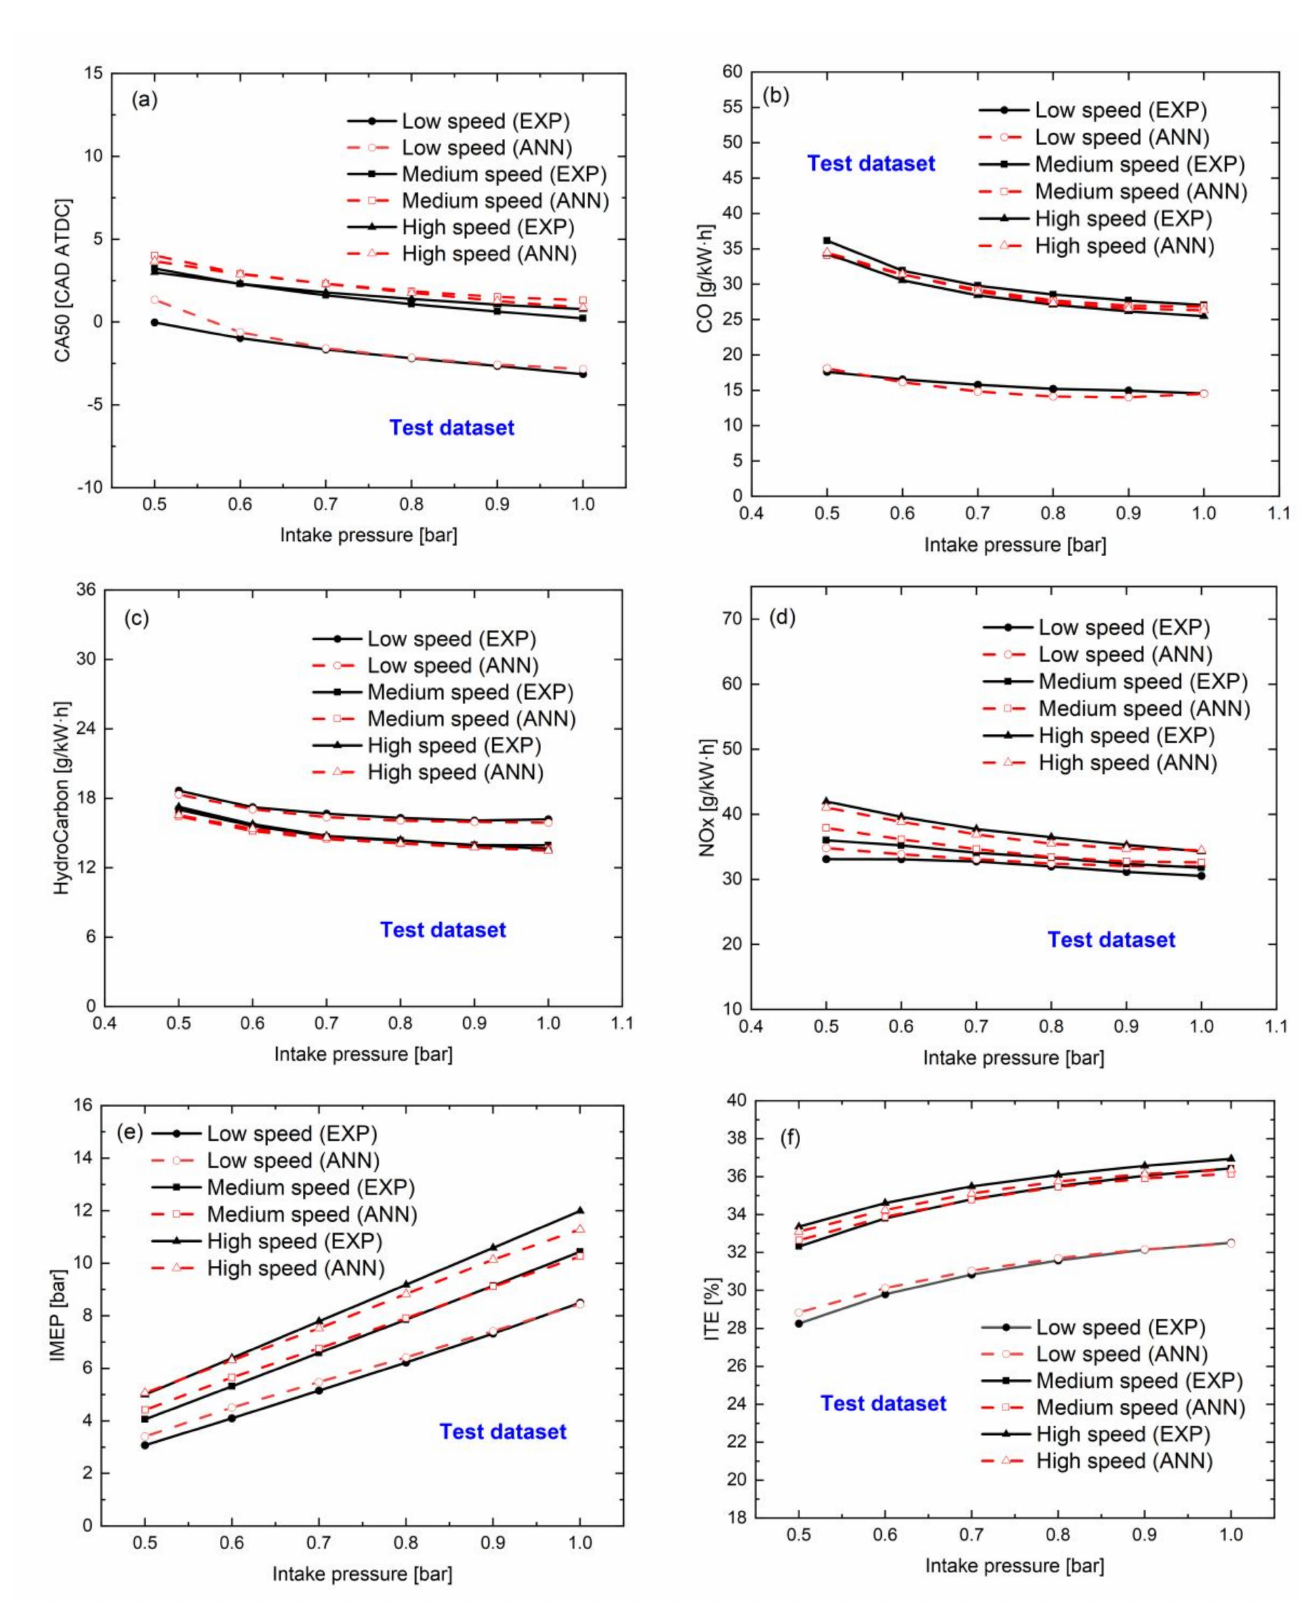
Figure 9. Comparison of ANN model predicted performance and emissions with calibrated data at the spark timing = − 20 CA ATDC for the steady test dataset: load effects: ( a ) CA50, ( b ) CO, ( c ) UHC, ( d ) NOx, ( e ) IMEP, ( f )